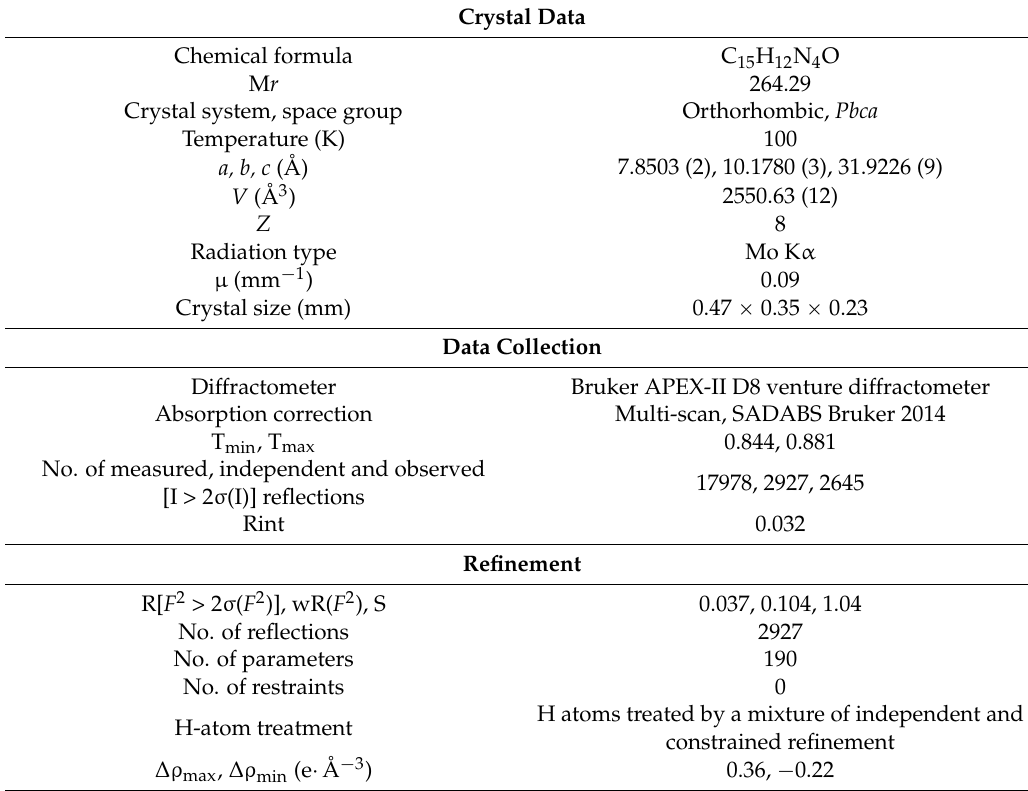
Table 2. The crystal structure and refinement data of compound 13